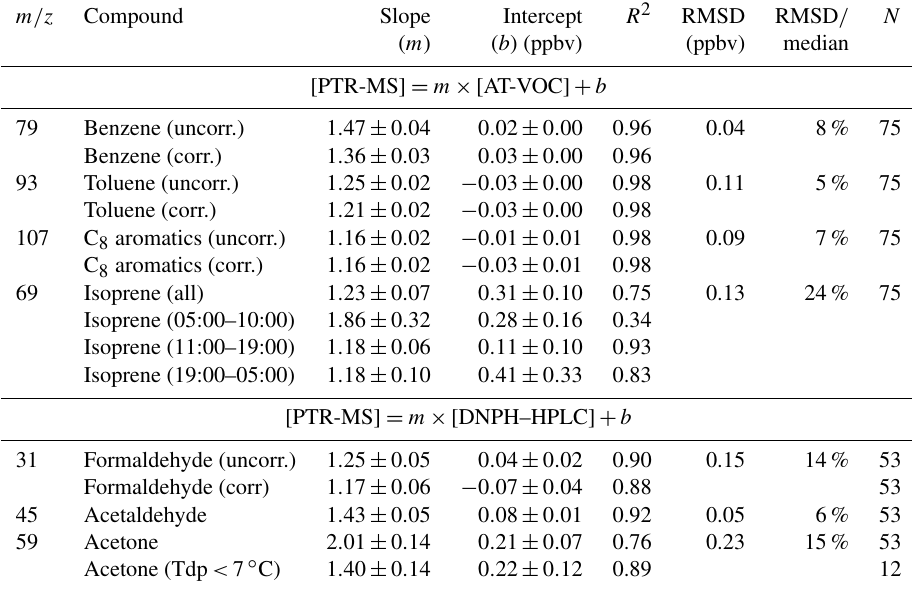
Table 5. The slope ( m ), intercepts ( b ) and correlation coefficients ( R 2 ) from the RMA regression analysis between the PTR-MS, AT-VOC and DNPH–HPLC measurements. Also included are the estimates of random measurement uncertainty expressed as RMSD for each species and the ratio of the RMSD to the median PTR-MS value expressed as a percentage (%). m/z Compound